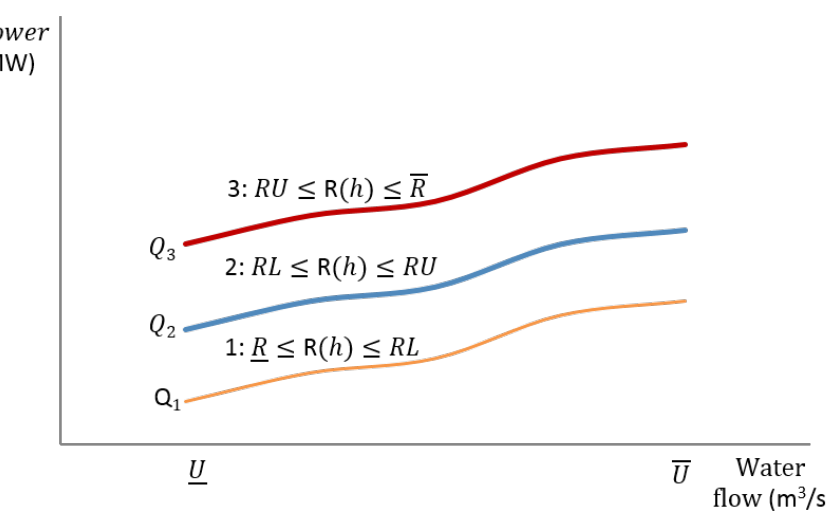
Figure 5. Performance curves for hydro